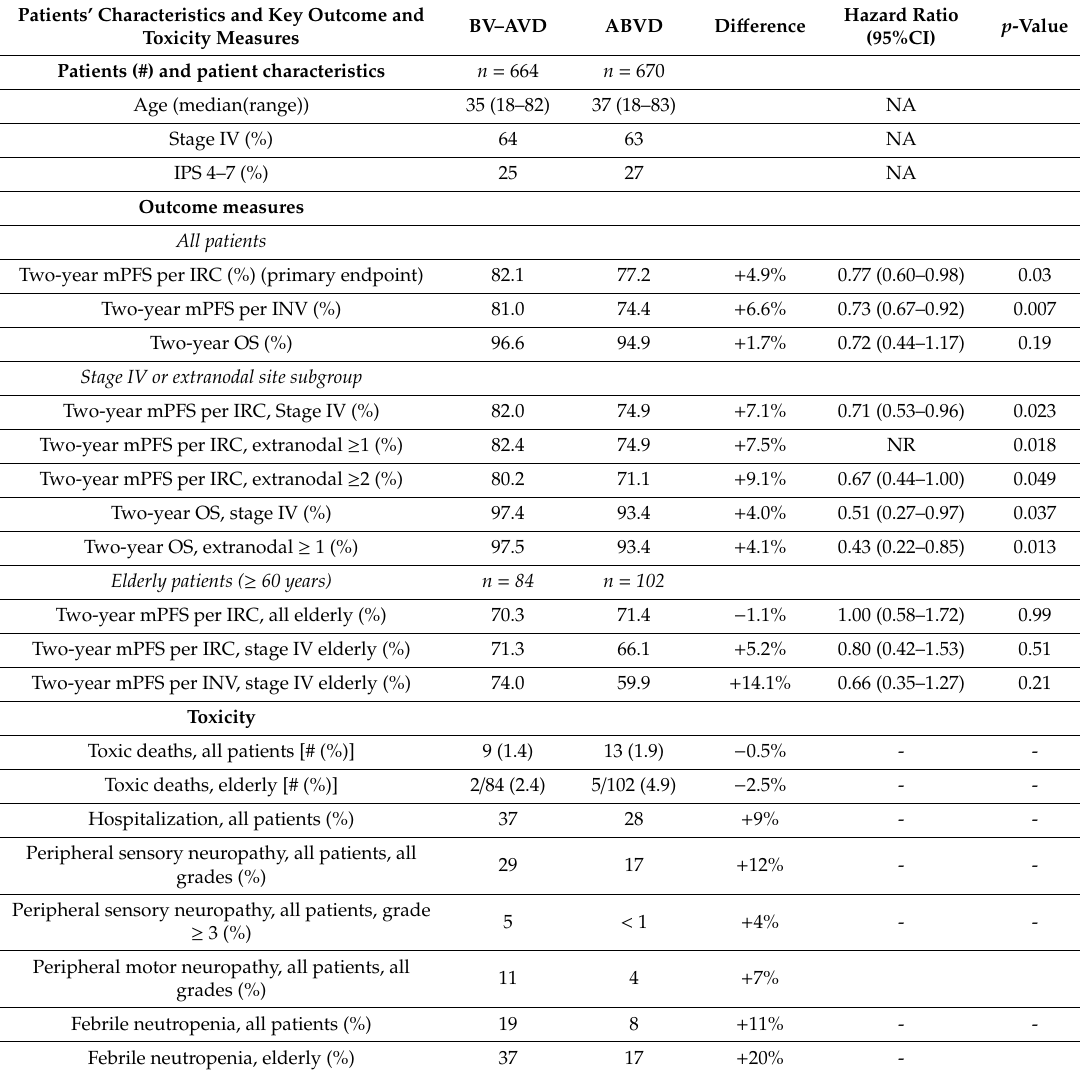
Table 4. Findings of the phase III ECHELON-1 randomized trial comparing six cycles of BV-AVD versus ABVD in stage III / IV cHL